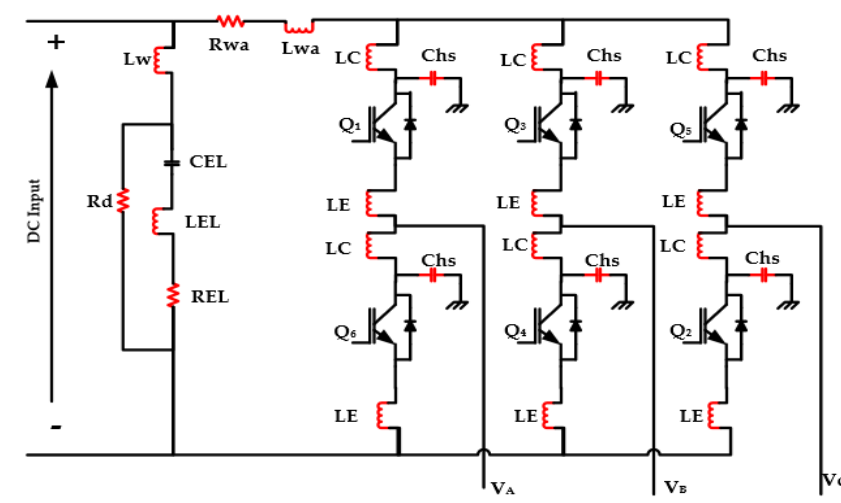
Figure 4. Circuit model of the inverter (parasitics elements are outlined in red).